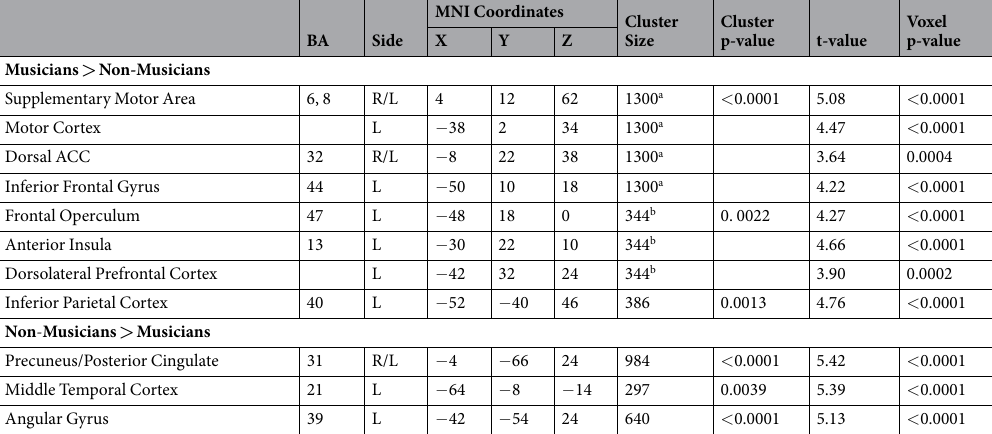
area and the motor cortex), left prefrontal areas (inferior frontal and dorsolateral cortices), as well as the insula and the inferior parietal cortex. Further, in musicians we found a greater deactivation of the default brain net- work, in line with the expected deactivation of the temporoparietal junction. In the case of the musicians a corre- lation was found between the amount of time spent improvising and the activation of the supplementary motor